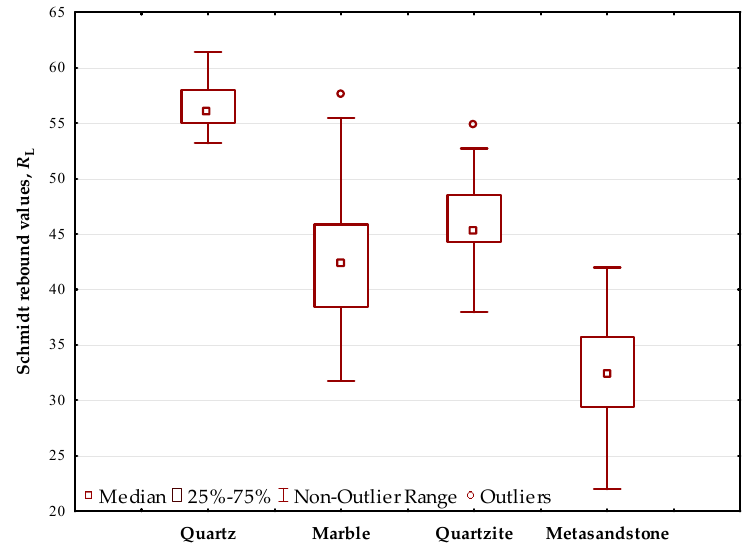
Figure 7. Schmidt rebound values ( R L ) of all materials used.